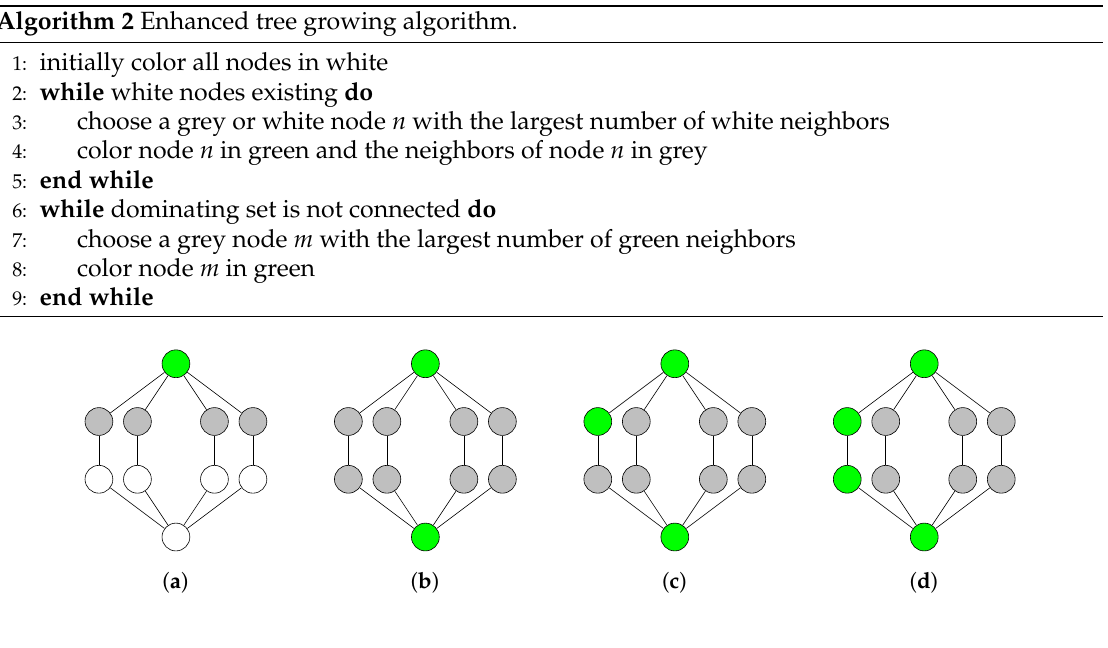
Figure 8. Enhanced tree growing algorithm. The dominators are colored in green. The non-dominators that are adjacent to at least one dominator are colored in grey. ( a , b ) The algorithm arbitrarily chooses a node with the largest number of white neighbors. The chosen node is colored in green and its neighbors are colored in grey. ( c , d ) The algorithm arbitrarily chooses a grey node with the largest number of green neighbors. The chosen node is colored in green. The algorithm stops in ( d ) because each node is colored in either green or grey and the set of green nodes is